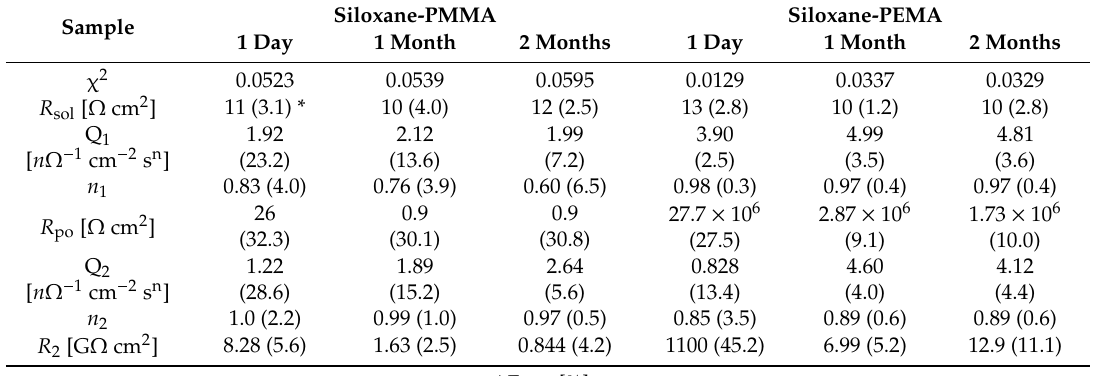
Table 5. Fitting parameters for the impedance measurements plotted in Figures 9 and 10 using denoted electrical equivalent circuit.